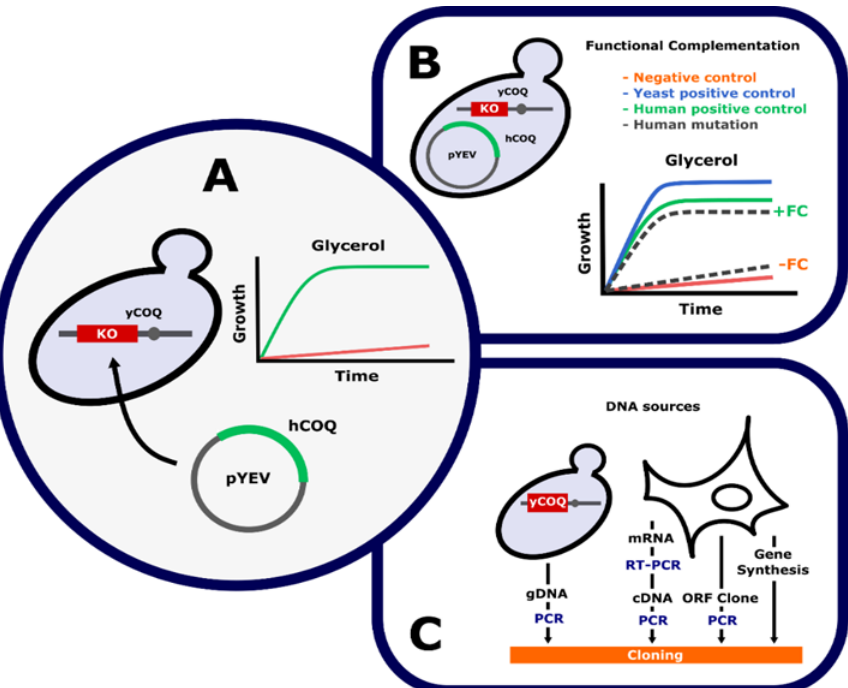
Figure 1. Functional complementation of human genes in the yeast model. Functional complemen- tation studies can perform the functional validation of genetic variants found in patients. ( A ) In a functional complementation assay, the expression of the human gene ( hCOQ ) using a yeast expression vector (pYEV) can recover the defect (CoQ 6 deficiency) in a null mutant yeast strain defective in the hCOQ orthologous gene ( yCOQ ). Positive complementation restores the growth of yeasts in glycerol media, a non-fermentable carbon source. ( B ) Functional complementation requires the presence of three controls: negative (empty vector), yeast positive (the wild-type yeast gene as control of methodology), and human positive (the human wild-type gene as a control to secure negative results). Using the same cloning and expression conditions, it should be possible to study the functionality of genetic variants found in patients. Positive growth indicates that the mutation does not affect CoQ biosynthesis, and a negative result means that the mutation affects CoQ biosynthesis and, therefore, could be responsible for the pathology. ( C ) Sources of DNA to build plasmids used in functional complementation assay, from yeast and human